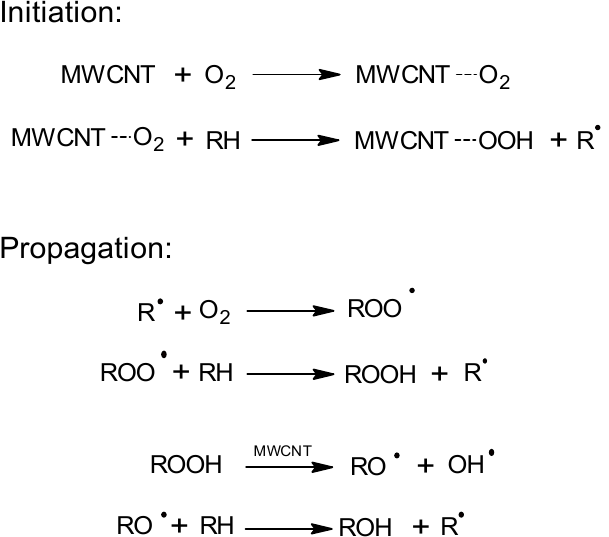
Figure 1. The free-radical oxidation mechanism on MWCNT (multiwalled carbon nanotubes).